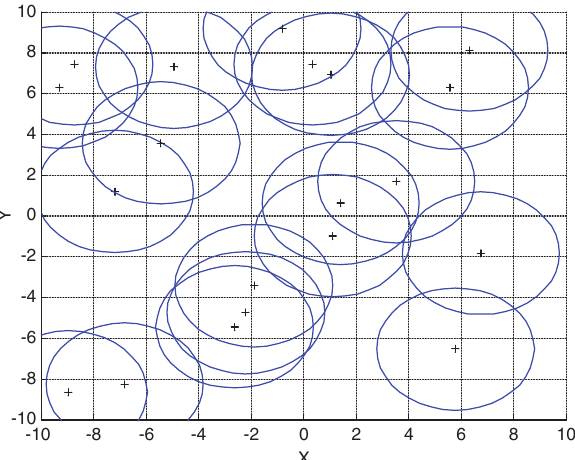
Figure 4: The Node Layout When the Population Size Was 30.